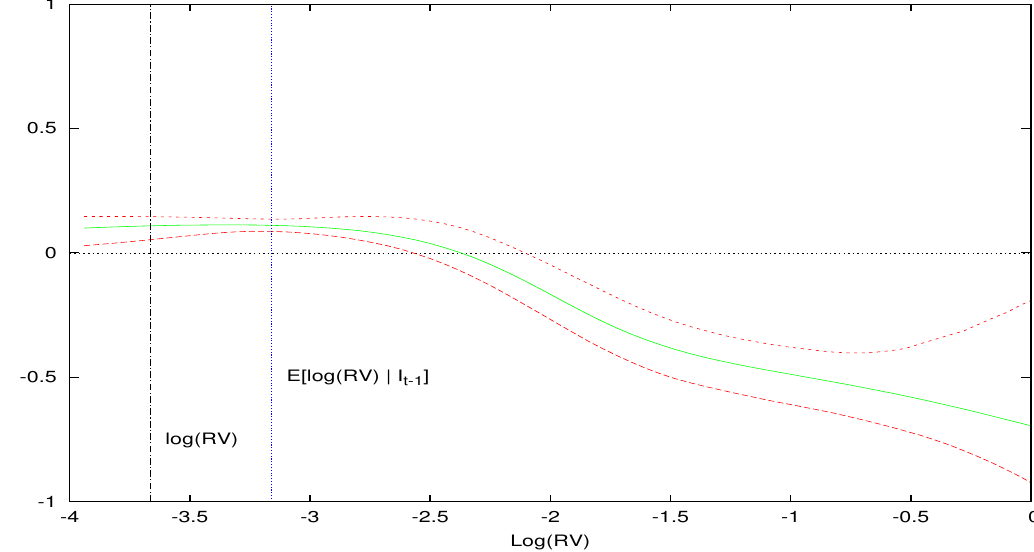
Figure 4. Expected excess return given log realized variance for the information set I t − 1 where volatility is low. This figure displays the expected excess return and 0.90 density intervals as a function of log ( RV ) conditional on the information set I t − 1 , t = 1964 : 10, which is a low volatility period. The expected log-realized volatility based on the model is blue, while the actual log-realized volatility for t = 1964 : 10 is the black vertical